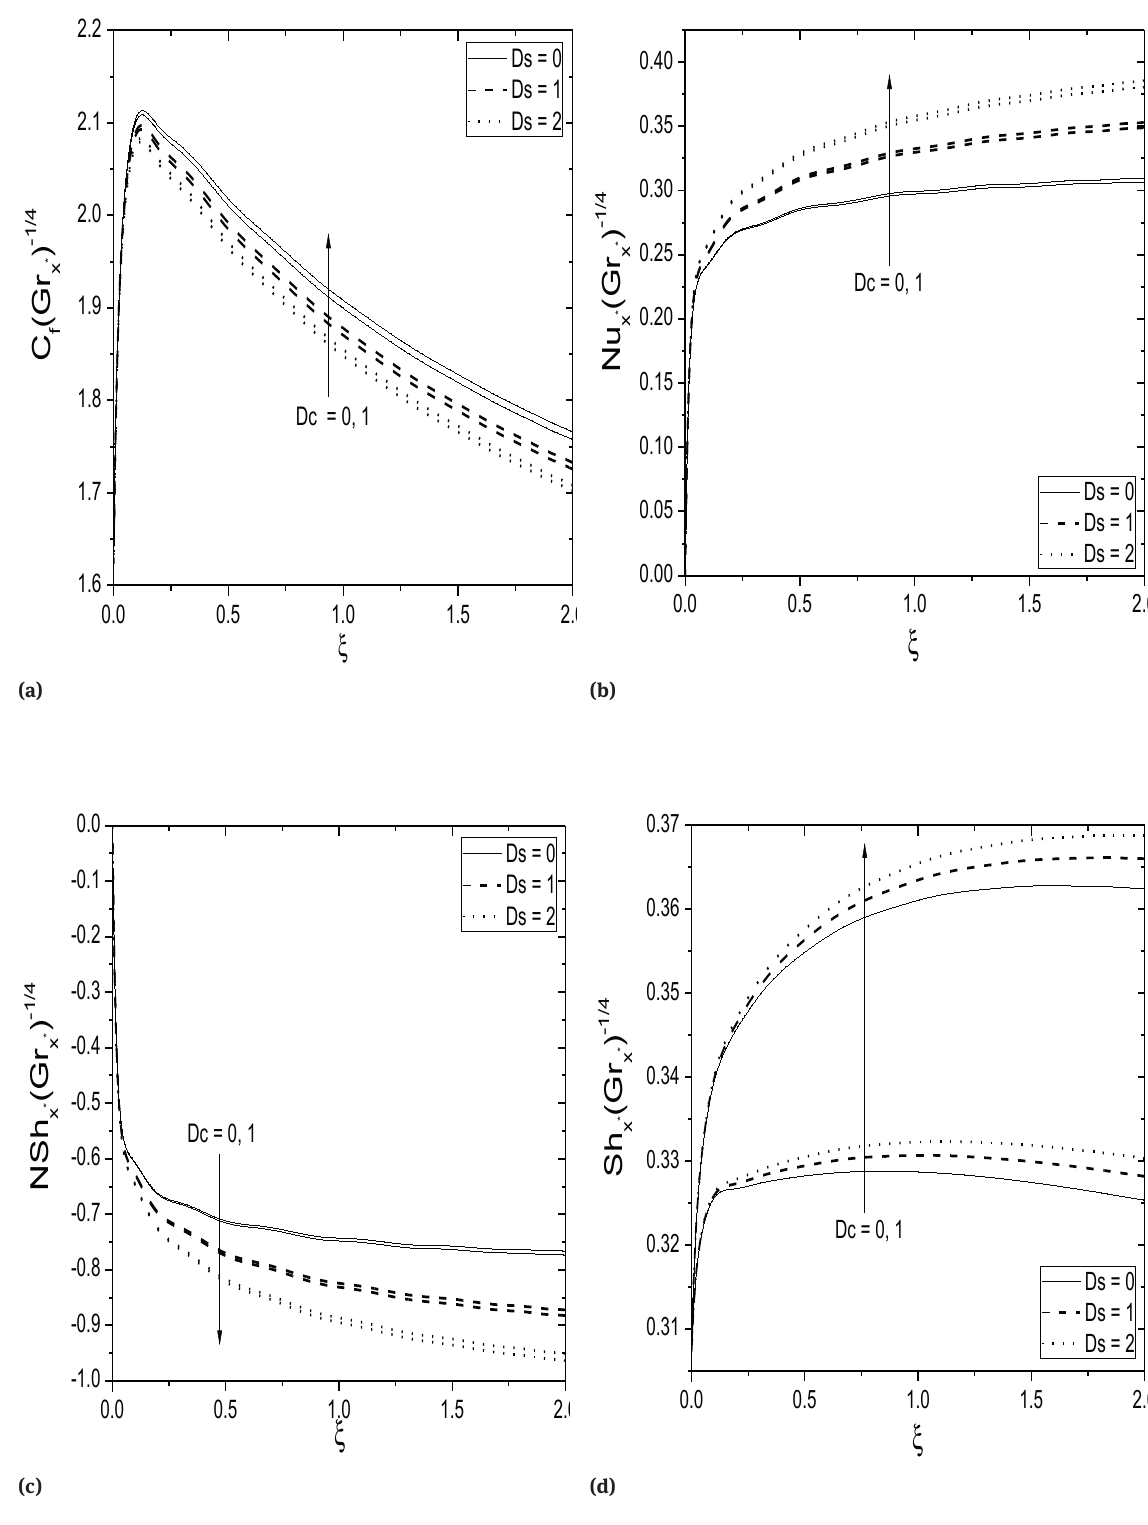
Fig. 7: Effect of Ds and Dc on (a) skin friction, (b) heat transfer rate, (c) nanoparticle mass transfer rate, and (d) mass transfer rate Fs = 0.5, Bi = 1.0